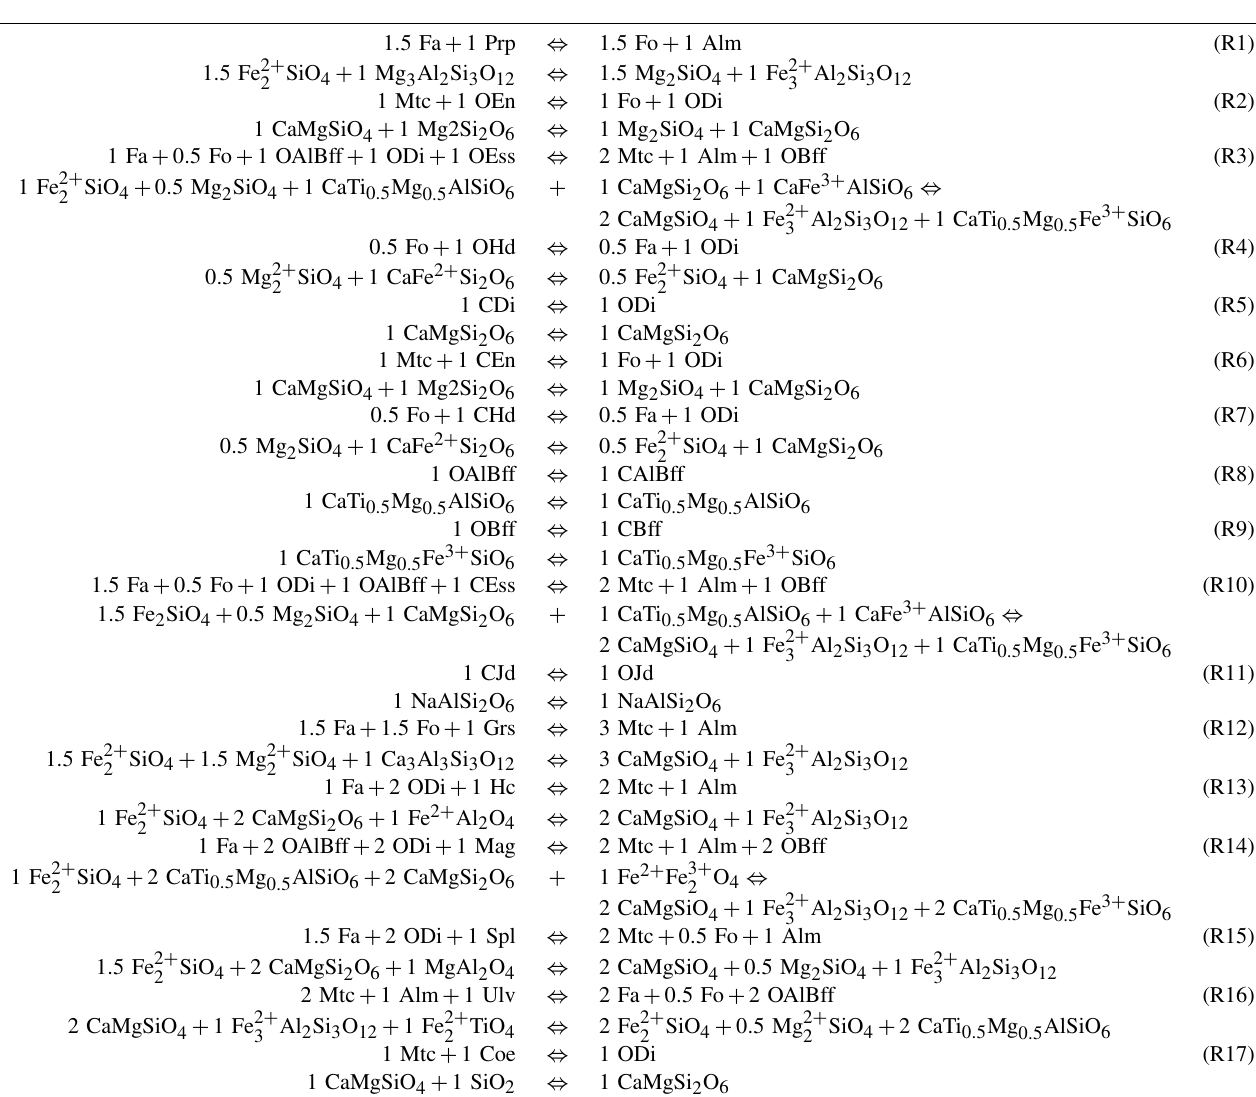
Table 2. Set of independent reactions for the list of mineral components in Table